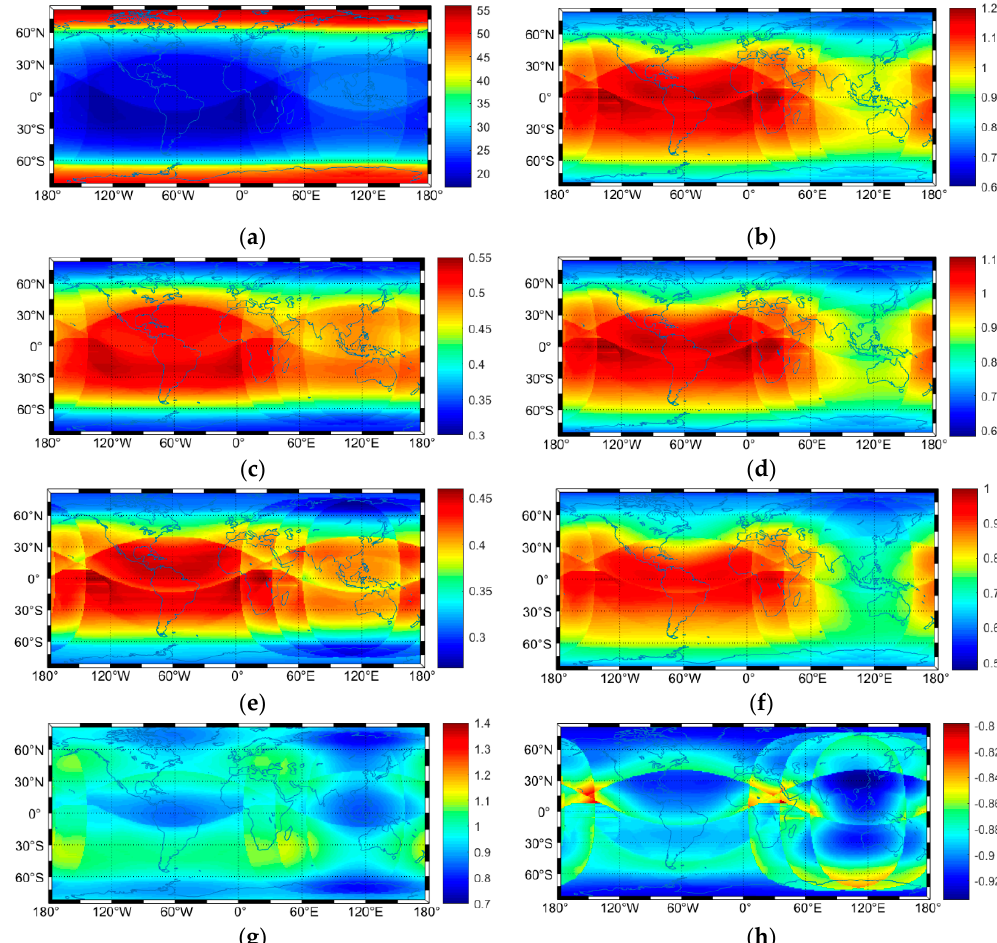
Figure 11. Estimated DOPs, positioning precision in longitude versus in latitude, and the correlation between station height and receiver clock difference of the BDS-3+LEO+HEO constellation with 5° CEA. ( a ) Number of visible satellites; ( b ) GDOP; ( c ) HDOP; ( d ) PDOP; ( e ) TDOP; ( f ) VDOP; ( g ) The ratio of positioning precision between the longitude component and the latitude component; ( h ) The correlation level between station height and receiver clock difference.